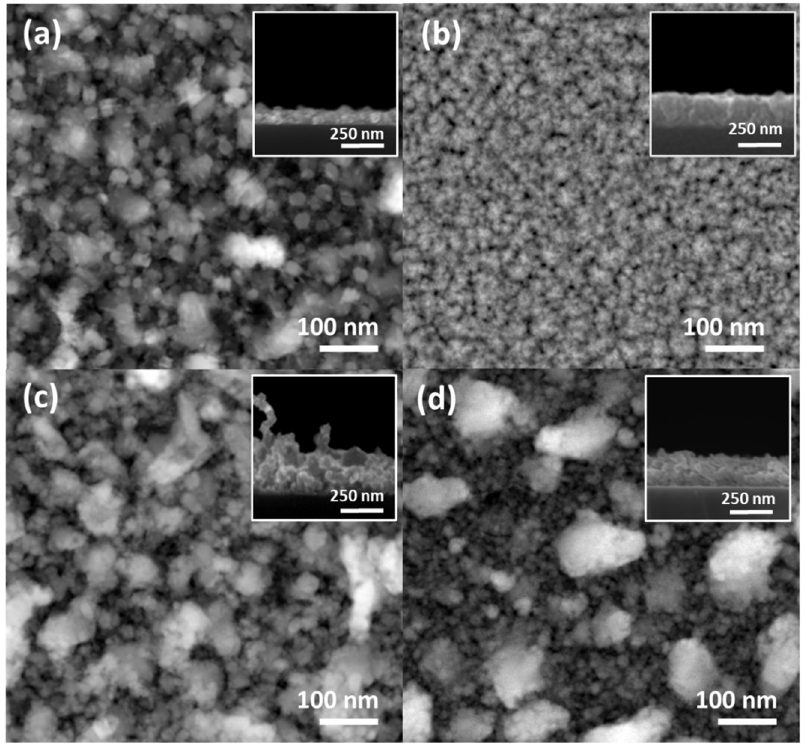
Figure 4. SEM surface images of the coatings: ( a ) pure Zn; ( b ) Zn-Fe alloy; ( c ) Zn NLs + Fe NPs; and ( d ) Zn-Fe NLs. The inset in each image represents the SEM cross-section for each sample.